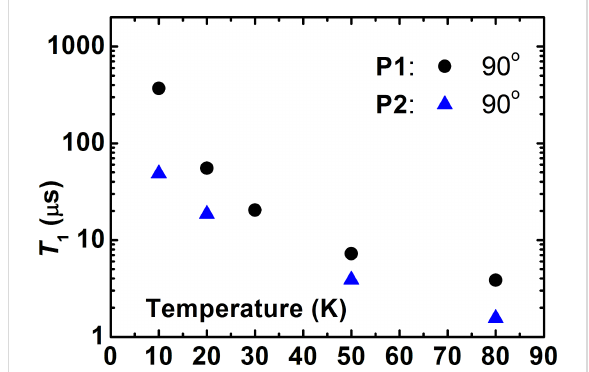
Figure 7: Temperature dependence of the longitudinal relaxation time T 1 of P1 and P2 at a frequency ν = 33.9 GHz for the 90° field orienta- tion.